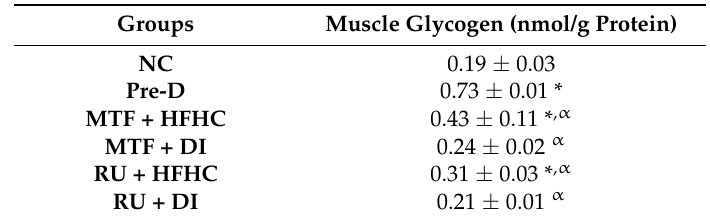
Table 2. Effects of the ruthenium complex on glycogen concentration of pre-diabetic animals during the treatment period. Values are presented as means ± SEM ( n = 6) in each group.